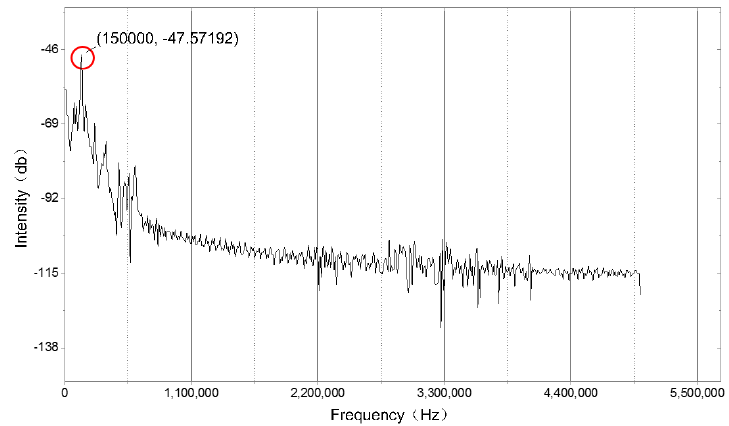
Figure 9. S pectrum of the simulated dynamic response signal.